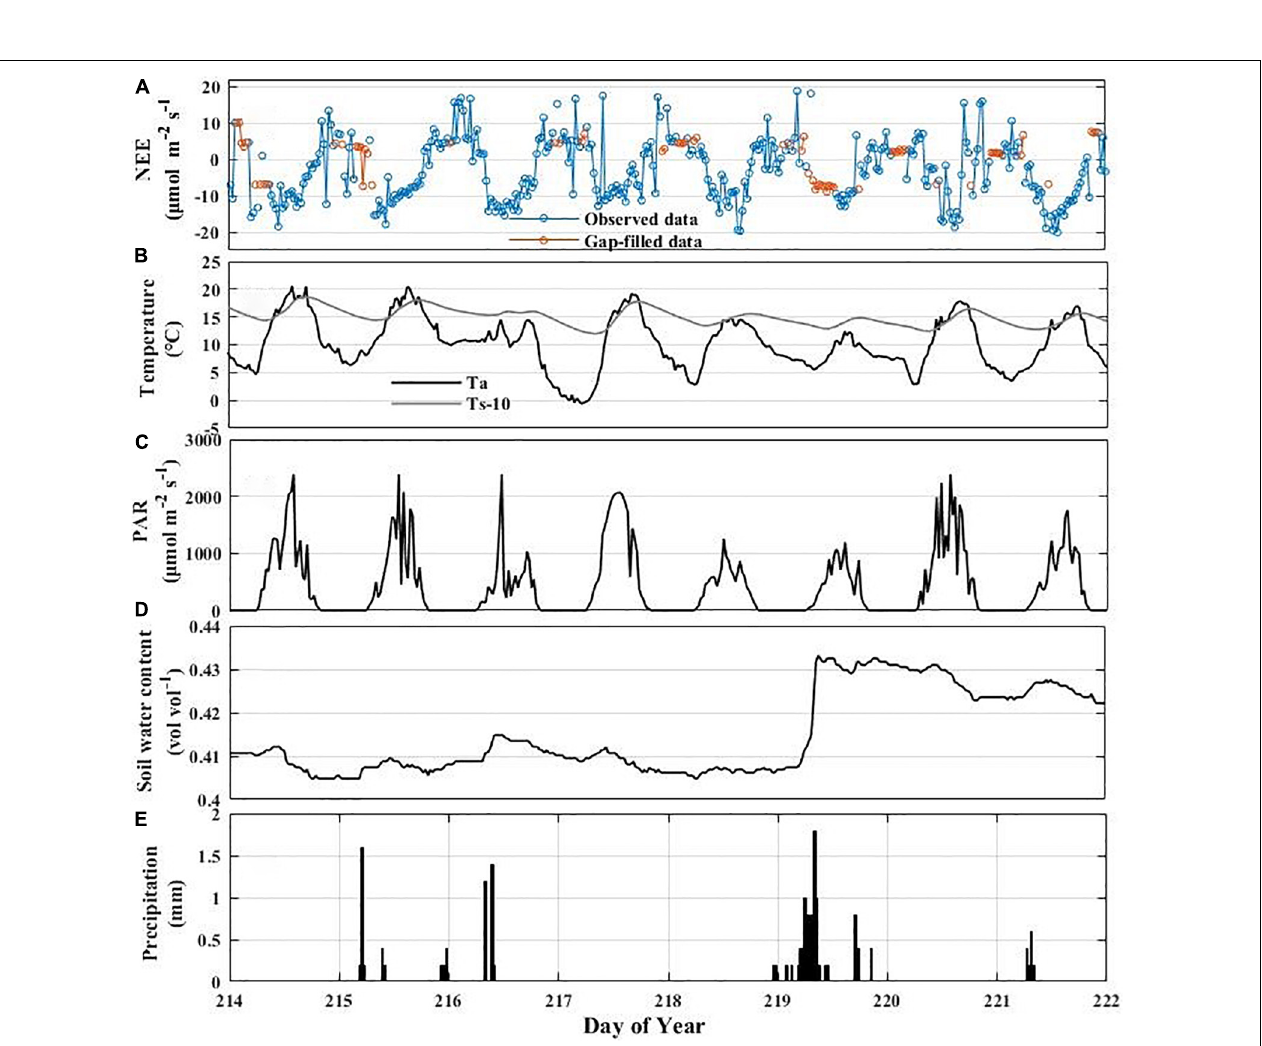
FIGURE 11 | Variation in NEE and environmental variables associated with rainfall events: synoptic variations of half-hourly NEE (A) , air temperature and soil temperature at 10 cm depth (B) , PAR (C) , soil water content (SWC) (D) , and precipitation (PPT) (E) .